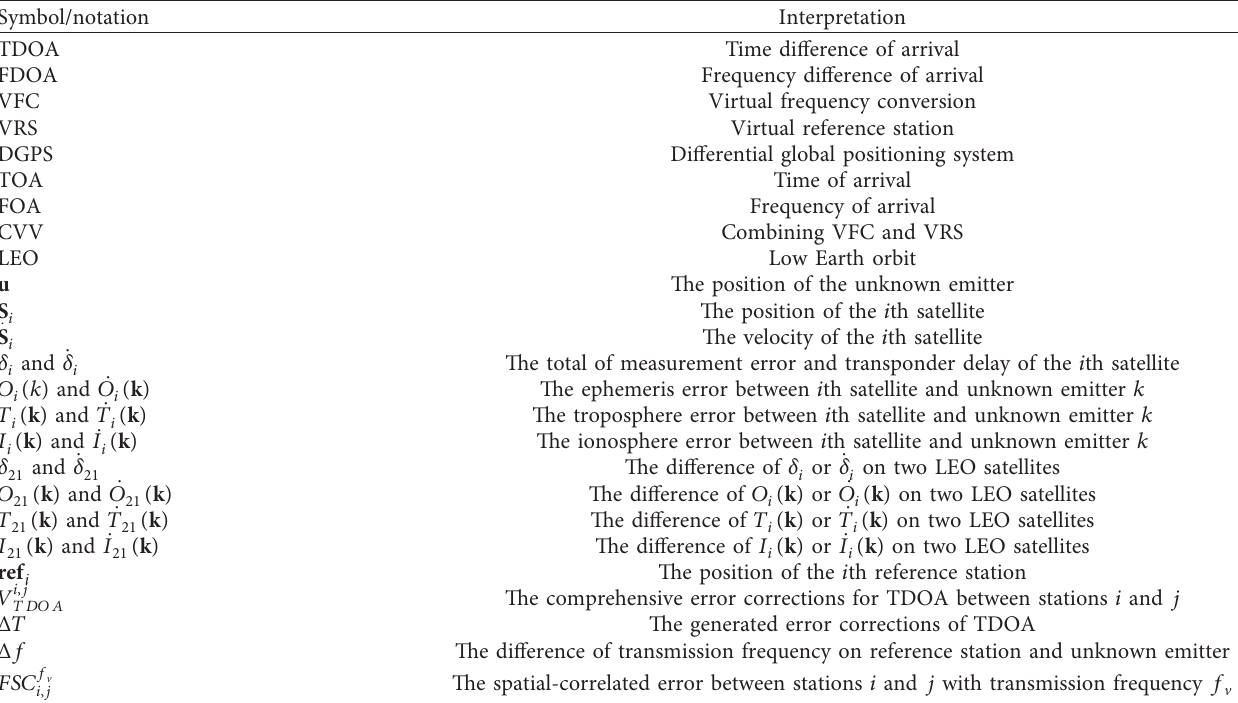
Table 1: Commonly used symbols and